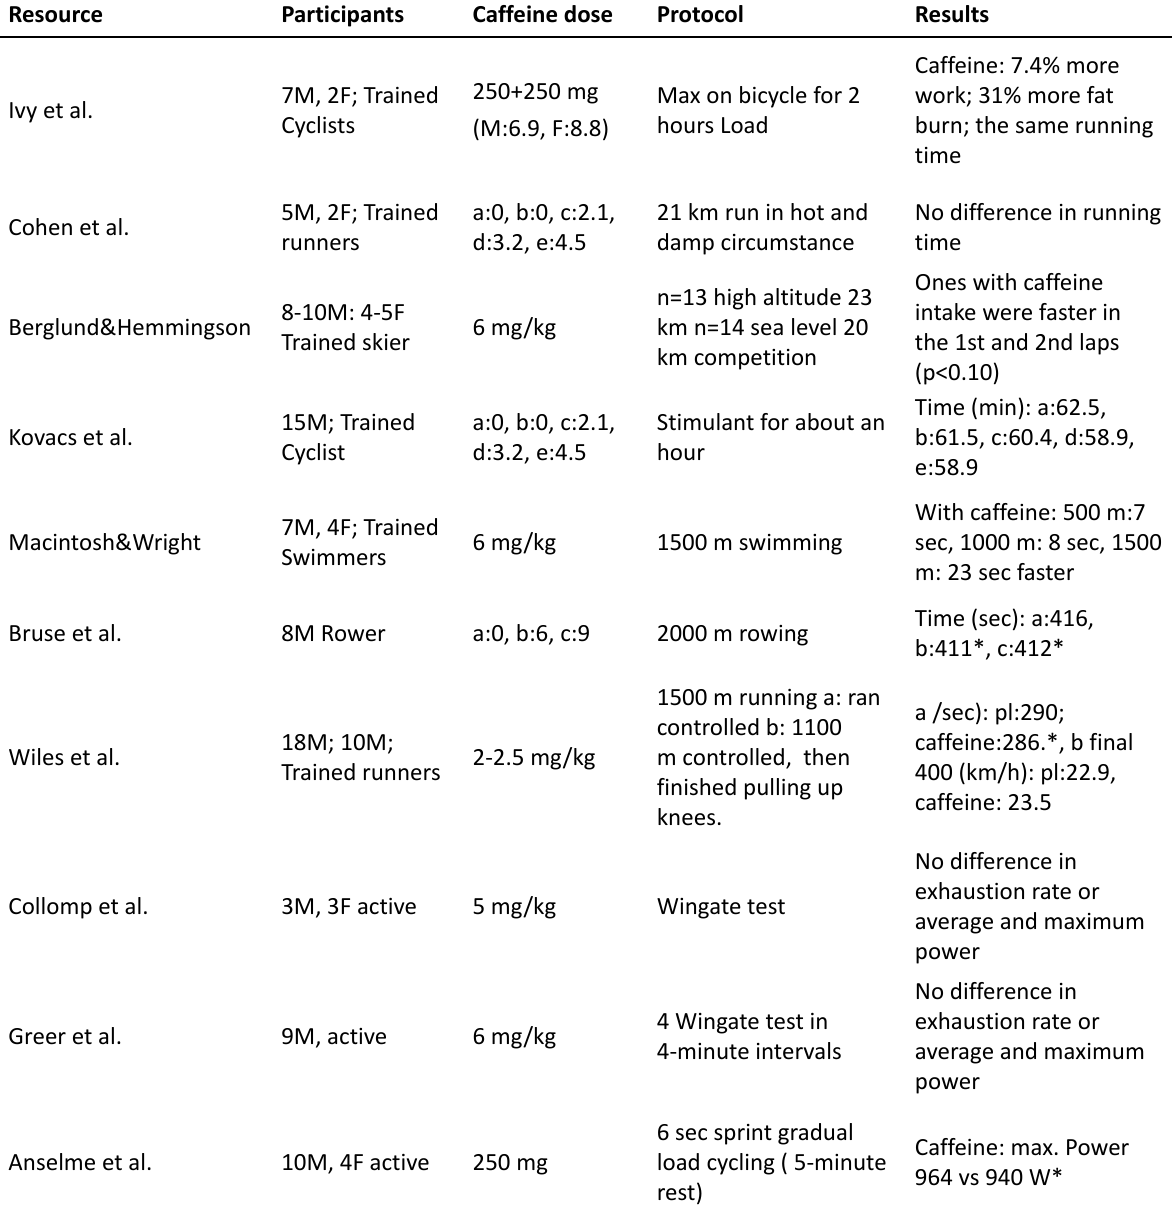
Table 1. Summary of The Study on The Effect of Caffeine on Exercise Performance